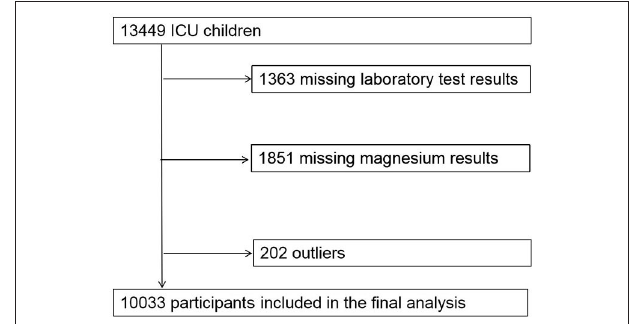
TABLE 2 | Characteristics of clinical laboratory results of study participants.